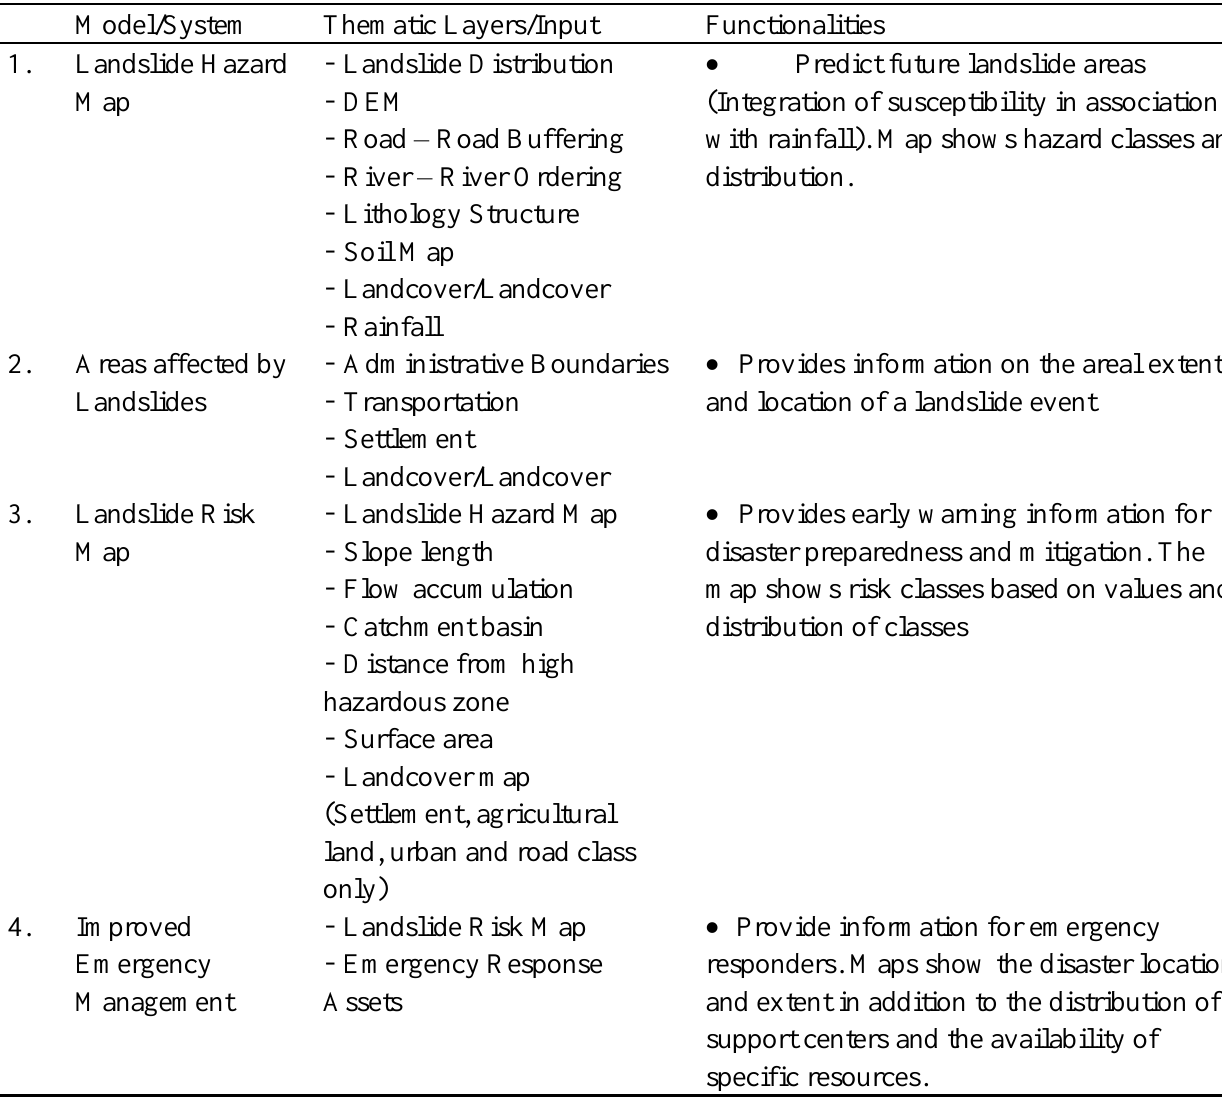
Table 2. Landslide disaster analysis in GIS Environment, input/output products and